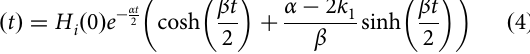
Fig. 5 Hydrogen chemical potential for a reverse gradient Si HJ interface. The reversed-gradient stacks were constructed so that the Si density (red), as described by the RDF1(z), exhibited a minimum at the interface. The Si density minimum induced a corresponding minimum in μ H ( z ) (blue). The reversal of the μ H ( z ) gradient induced a force on the mobile H atoms toward the